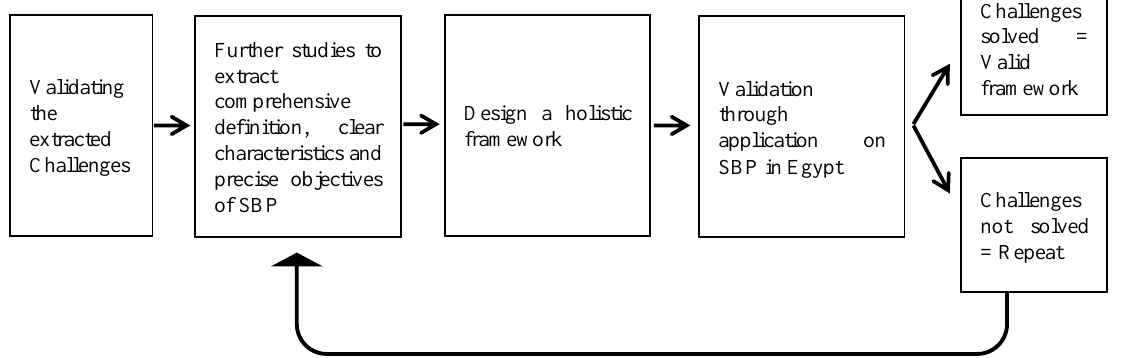
Figure 3. Action Plan of Designing and Validating a Framework to Face SBP Challenges;source: